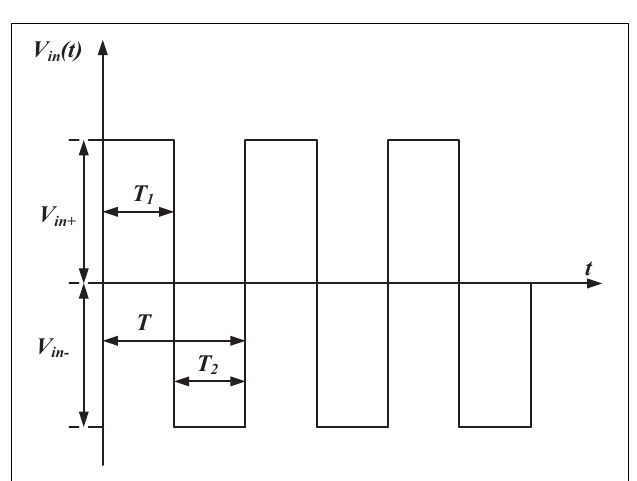
FIGURE 4 | Input voltage waveforms of half-wave rectifiers.